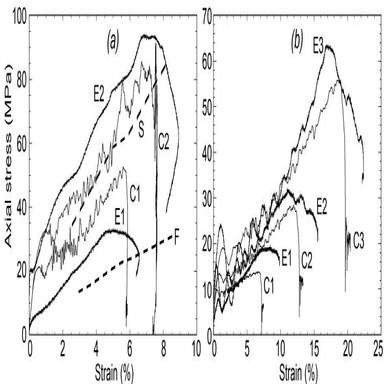
The calculated stress-strain response with fitted compaction kinetic compared with the experiments: for solid glass microspheres, ρ0 = 1.53(1), 1.52(2), 1.56 (F), 1.45(S) g/cm3 (a) and for high purity silica sand, ρ0 = 1.38(1), 1.37(2), 1.37(3) g/cm3 (b), where 1, 2 and 3 correspond to different strain rates.